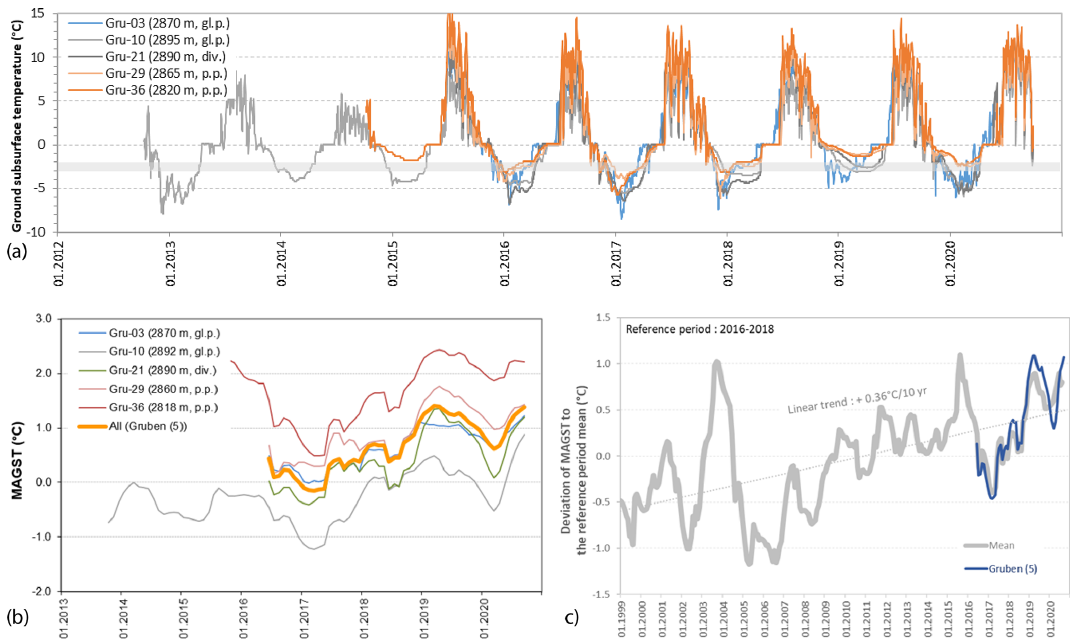
Figure 3. Daily ground surface temperature on the Gruben rock glacier (gl.p.: glacier-affected part; p.p.: periglacial part; div.: transition zone) since 2013, with indication of the upper limit of BTS for permafrost conditions (horizontal light-grey bar) (a) , mean annual ground surface temperature (MAGST) (b) , and deviation to the reference period 2016–2018 in comparison with the overall signal measured on rock glaciers and debris landforms ( n = 2 to > 20) in the surrounding region (c) (data: PERMOS and University of